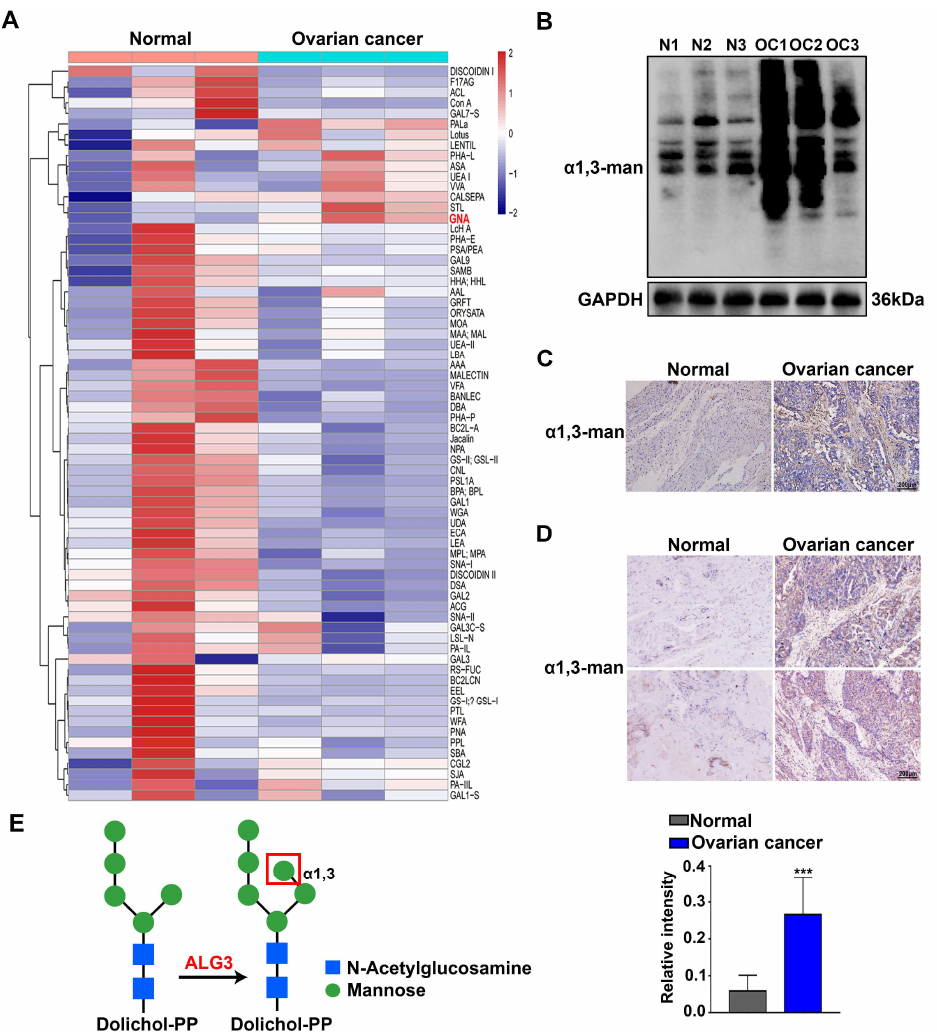
Figure 1. Increased α 1,3-mannosylation of glycoproteins in ovarian cancer tissues. ( A ) Heatmap of Lectin clustering analysis in normal ovarian and ovarian cancer tissues ( n = 3 pairs) measured by the Lectin chip. ( B ) Lectin blot analysis to detect α 1,3-mannosylation in normal ovarian (N1–N3) and ovarian cancer tissues (OC1 − OC3). ( C , D ) Lectin histochemical staining of α 1,3-mannose glycans in normal ovarian and ovarian cancer slides and tissue microarrays. Statistical analysis of the relative intensity of normal ovarian vs. ovarian cancer tissues in ovarian cancer tissue microarrays. The bar represents 200 µ m. ( E ) Diagram of α 1,3-mannosylation biosynthesis catalyzed by ALG3. N: normal ovary; OC: ovarian cancer. *** p <